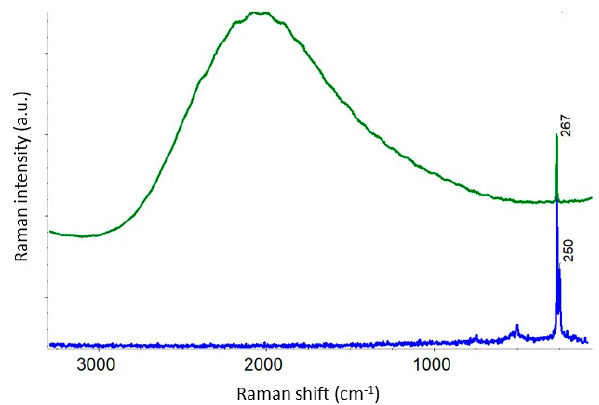
Figure 6. Raman spectra of GaAs obtained with 455 nm (blue) and 532 nm (green) excitations.